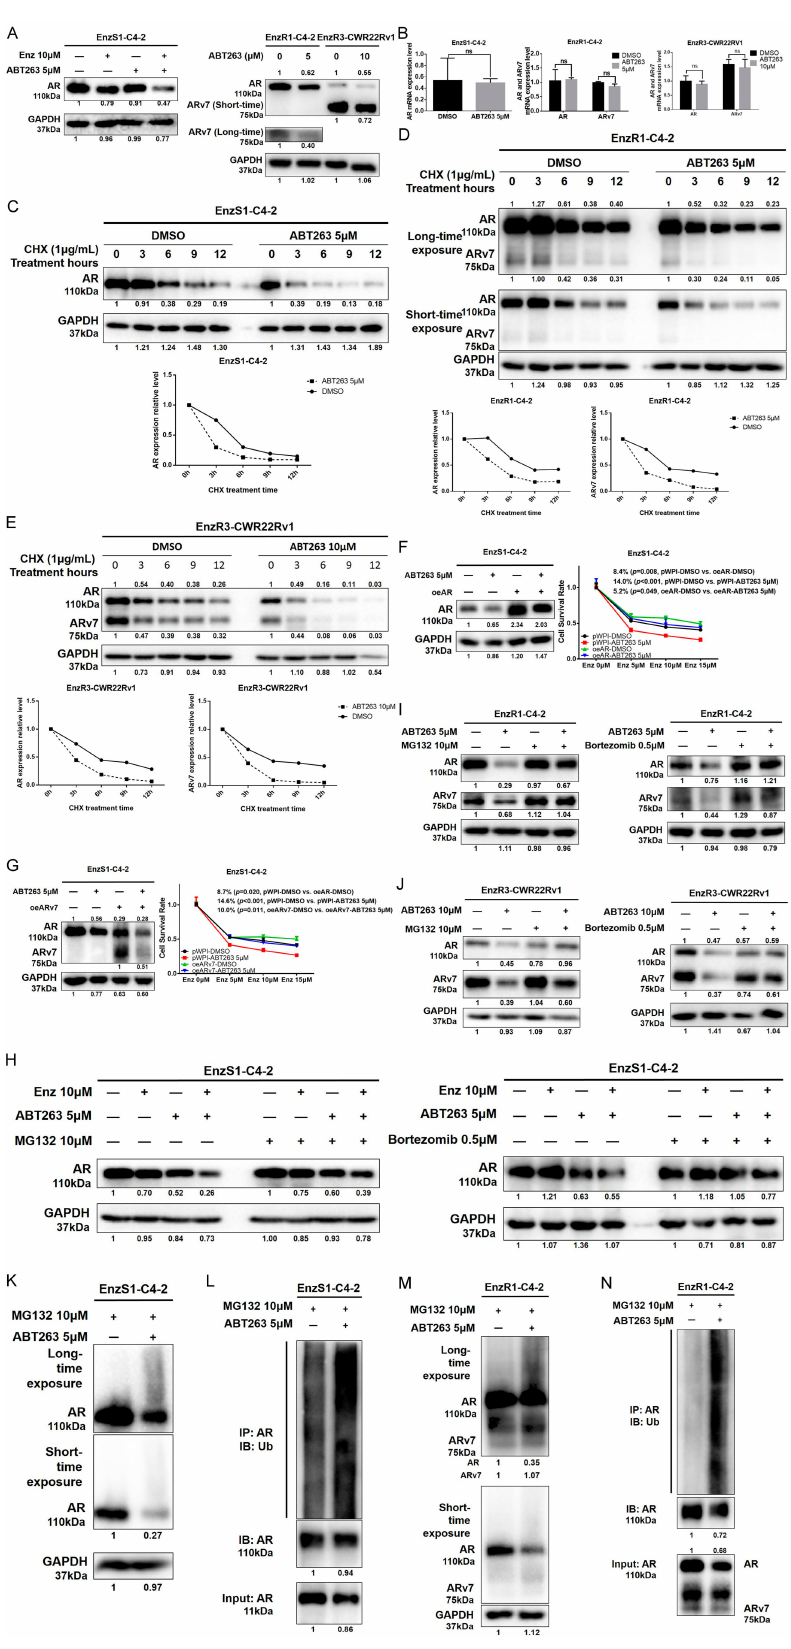
Figure 2. ABT263 increases ubiquitin-proteasome-dependent degradation of AR and ARv7. ( A ) ABT263 decreases AR and ARv7 protein expression. EnzS1-C4-2, EnzR1-C4-2, and EnzR3-CWR22Rv1